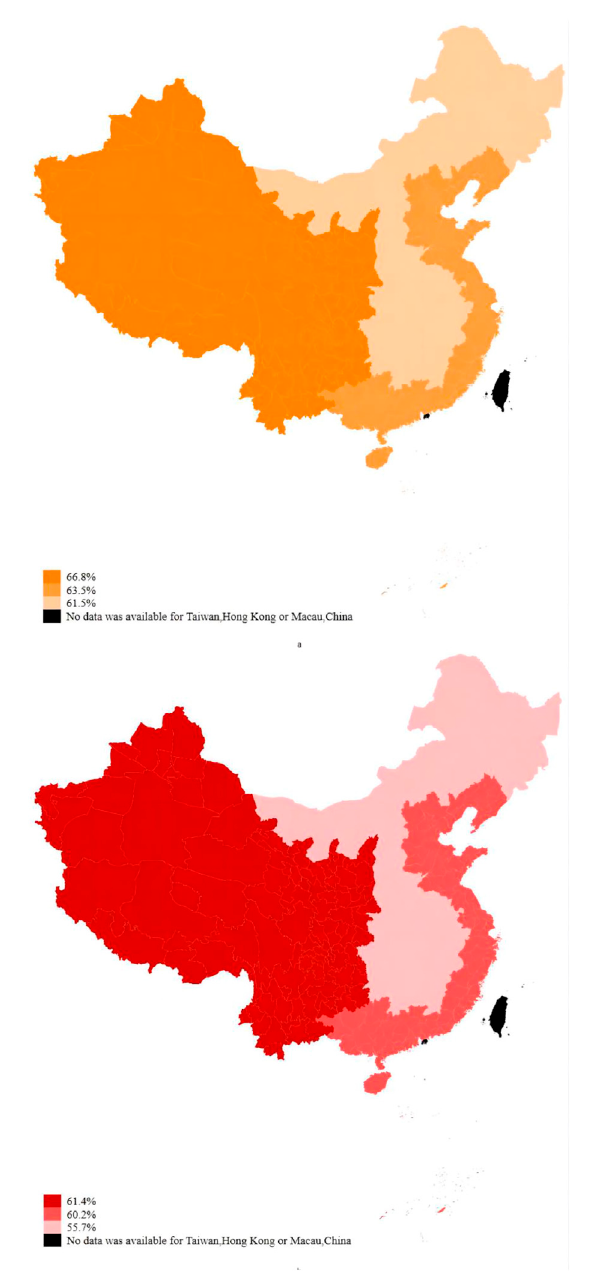
FIGURE 4 Distributionofresidentsfocusingonsafetyoref fi cacyindifferent regions of China (a:safety; b:ef fi